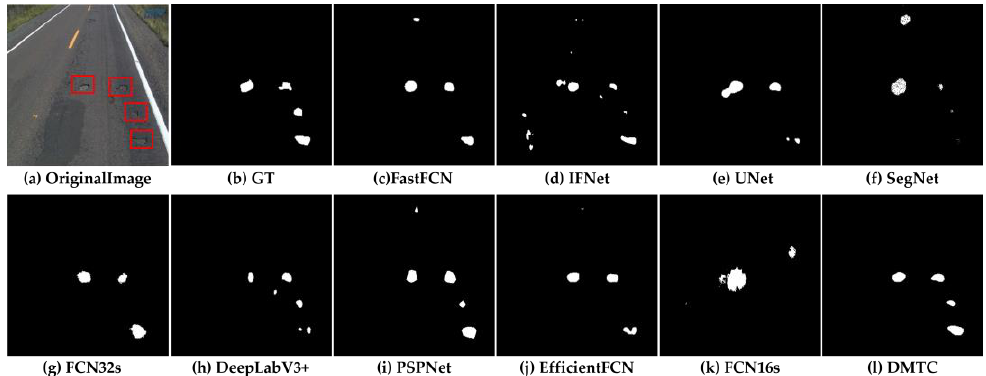
Figure 5. Visual comparison of the results of a series of segmentation methods for small potholes on CPRID. There is a red outline around the pits in the original image, a white outline around the pits in the label map and segmentation map, and black in the rest of the background.